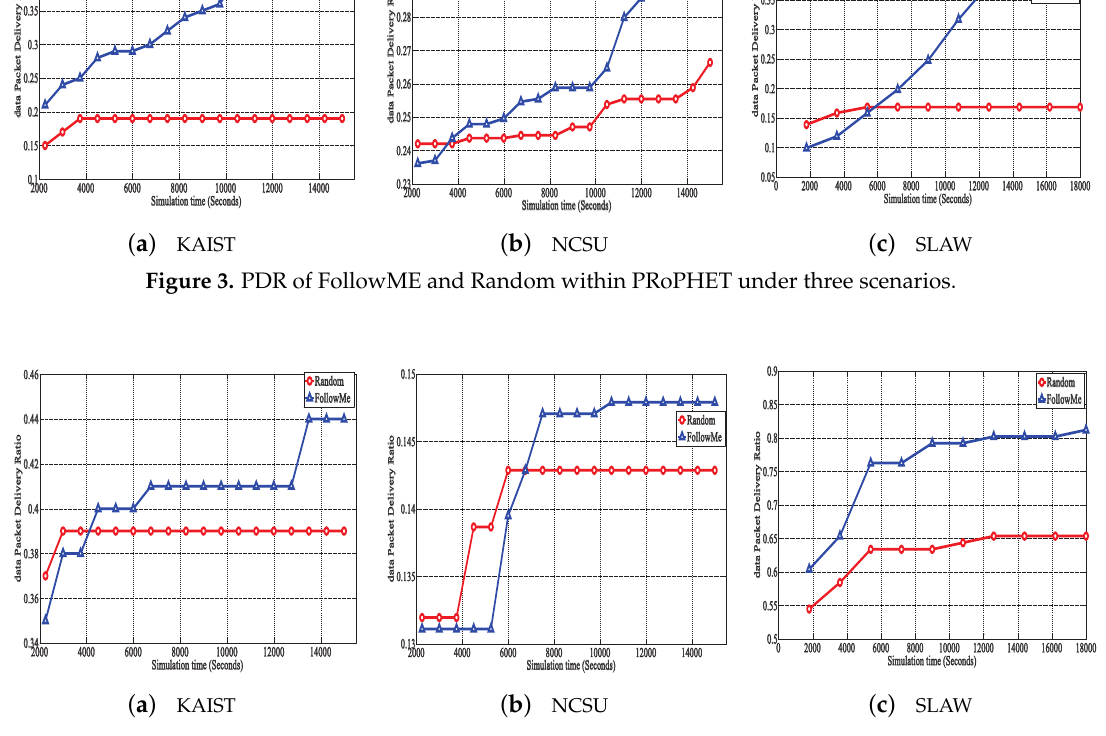
Figure 4. PDR of FollowME and Random within SimBet under three